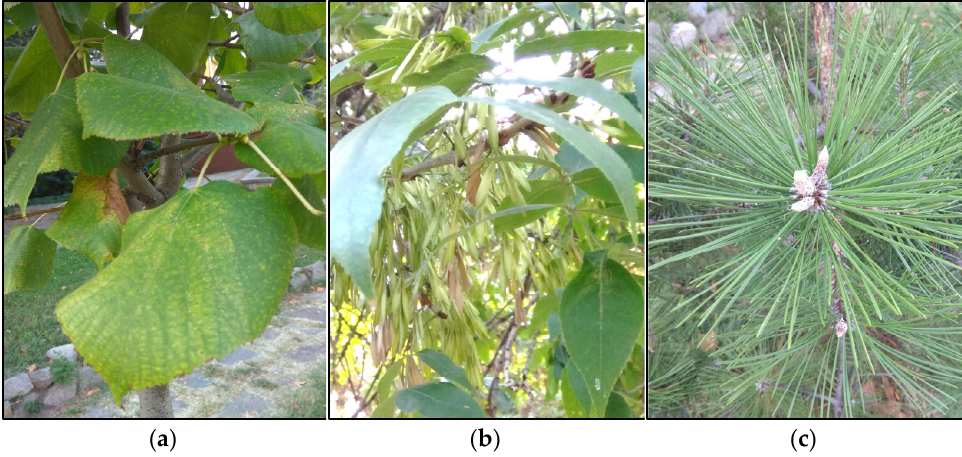
Figure 3. Leaf injuries observed on trees growing at Plot 3 (very high urbanization intensity): ( a ) Tilia tomentosa ; ( b ) Fraxinus excelsior ; and ( c ) Pinus nigra . tomentosa ; ( b ) Fraxinus excelsior ; and ( c ) Pinus nigra .